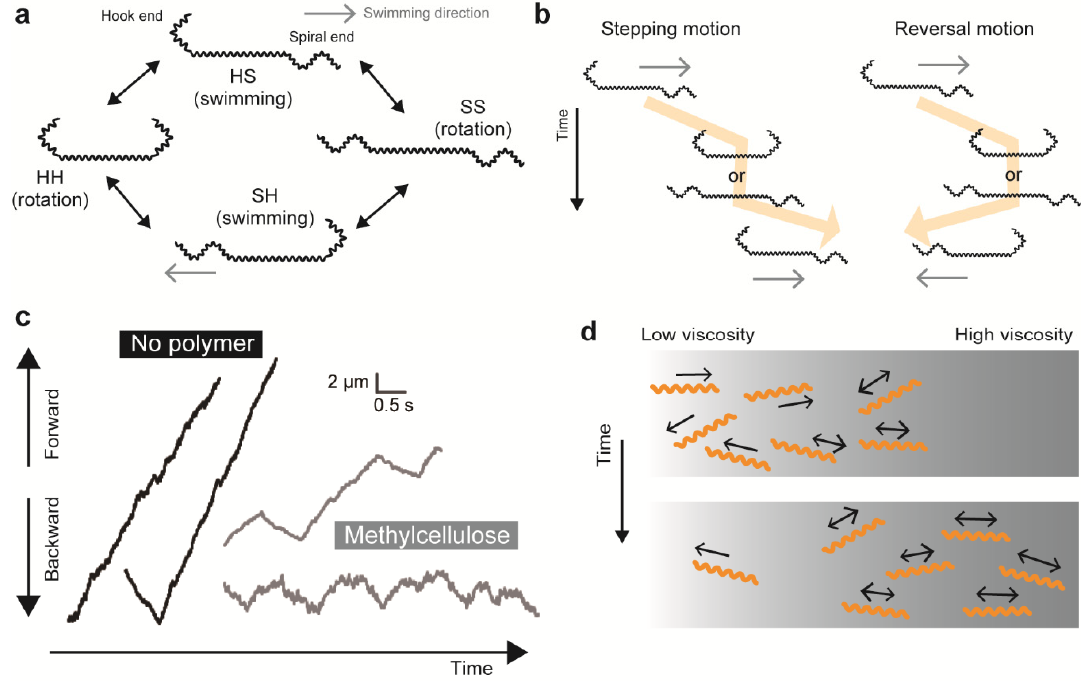
Figure 4. Effect of viscosity on Leptospira swimming. ( a ) Association of cell morphology and swimming in Leptospira . The spirochete can swim while displaying asymmetric morphologies (SH or HS), with the front end pointing towards the swimming direction and usually displaying a spiral shape. ( b ) Definition of stepping and reversal motions. ( c ) Reversal movements are enhanced by the